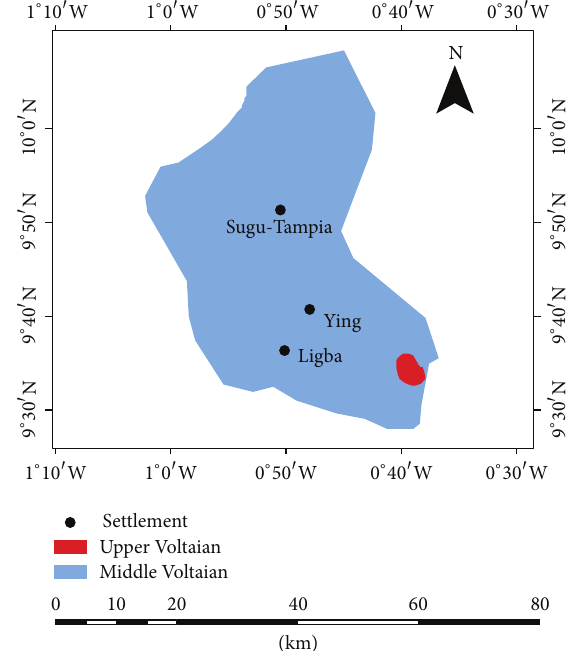
Figure 2: A geological map of the study area.